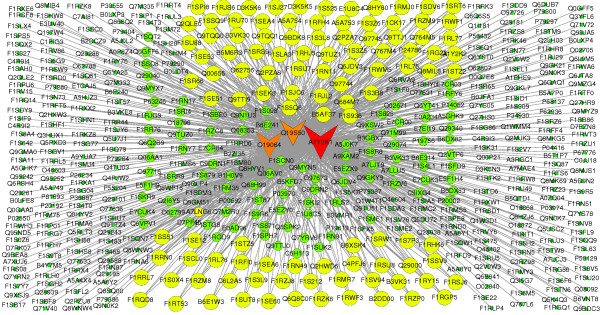
Part of the hub nodes of the merged network. The nodes represented by circles and V are proteins and the V nodes represent the three hub nodes A1Y2K1, O19064, and Q19S50. If the three hub nodes are removed, the network will be damaged.